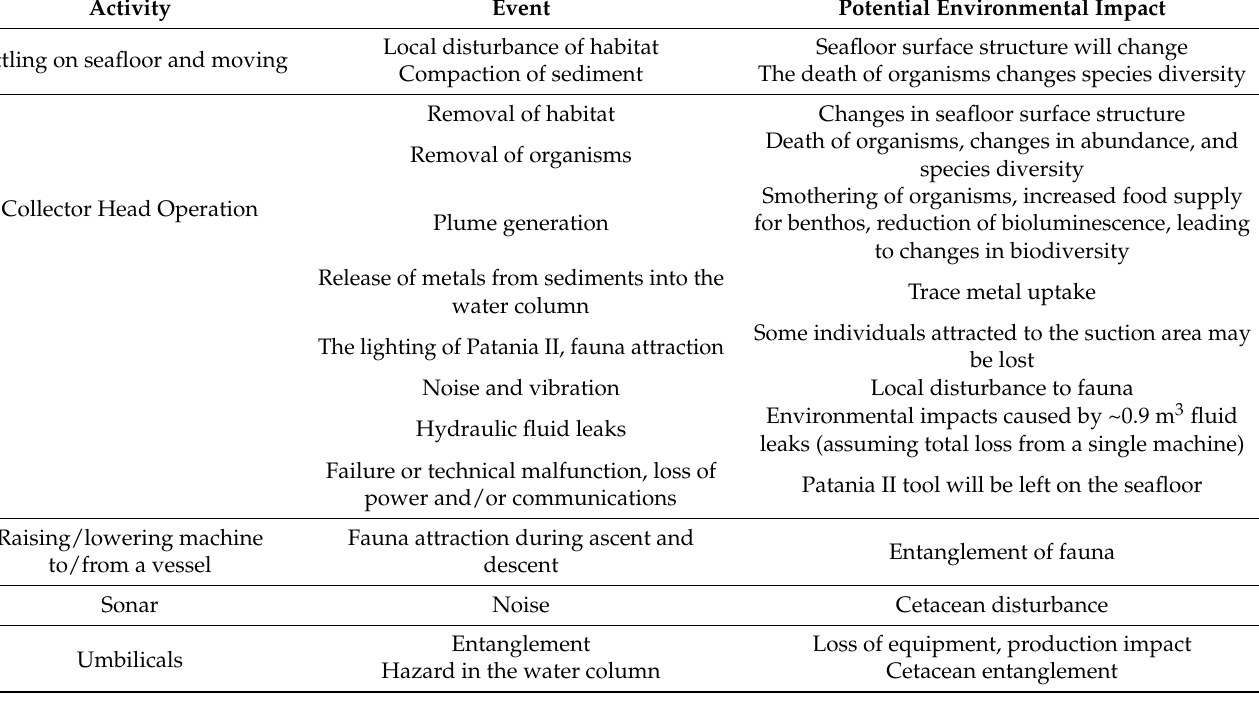
Table 3. Some of the environmental risks of the Patania II project (modified from GSR [47]).